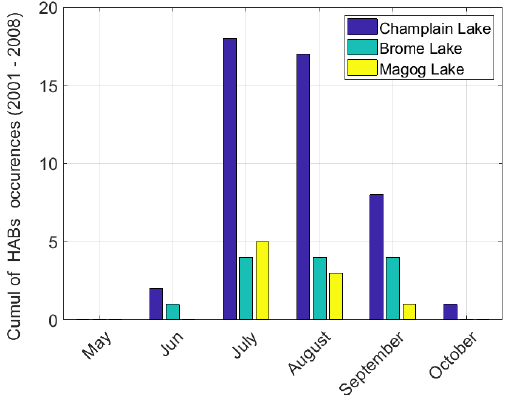
Figure 2. Occurrences of algal blooms episodes by month for Brome, Champlain, and Magog Lakes from 2001 to 2008.